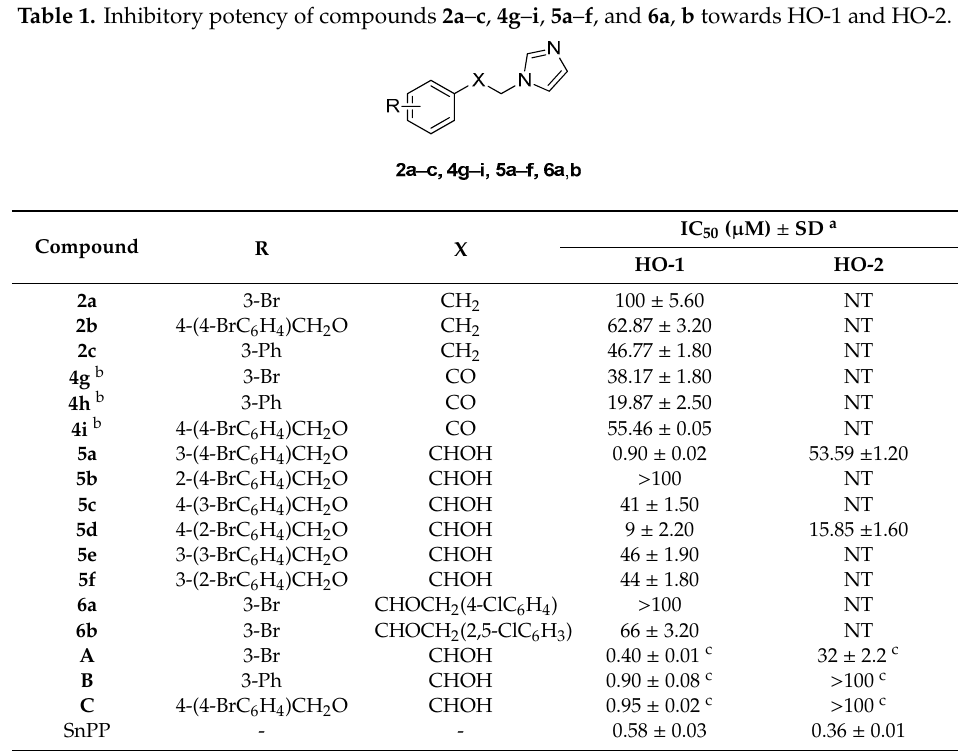
Table 1. Inhibitory potency of compounds 2a – c , 4g – i , 5a – f , and 6a , b towards HO-1 and HO-2.